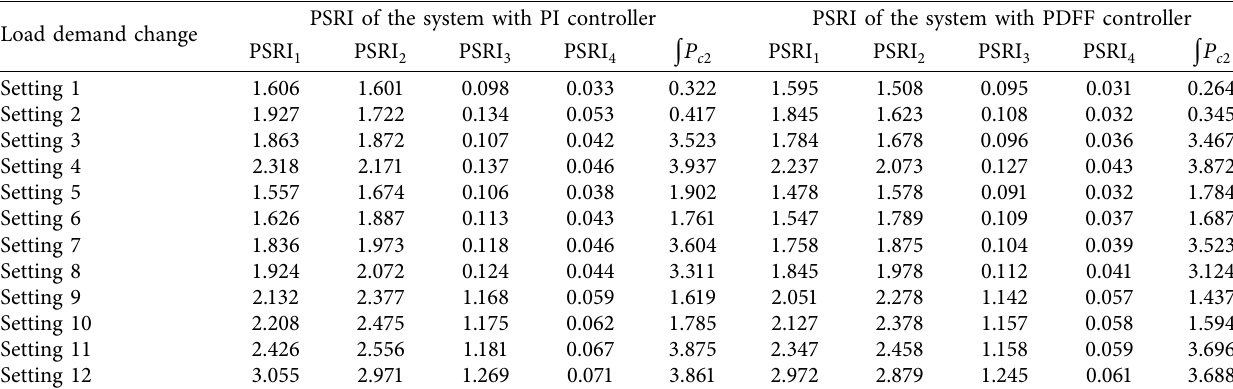
Table 4: PSRI of the power system under investigation for a different type of